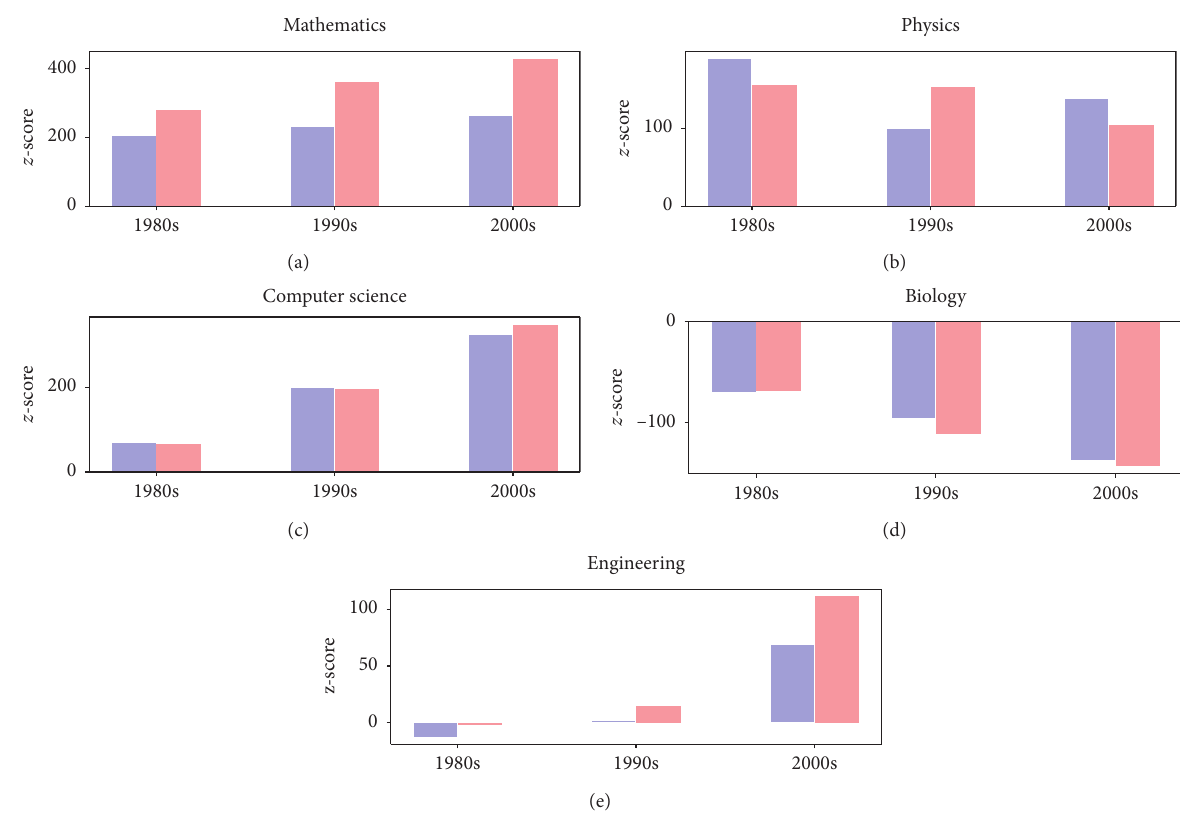
Figure 3: The aggregated z -score between complex system research and several selected academic fields. (a) Mathematics, (b) physics, (c) computer science, (d) biology, and (e) engineering. Specifically, blue bars mean how complex system research cites other fields, and red bars represent how other fields cite complex system